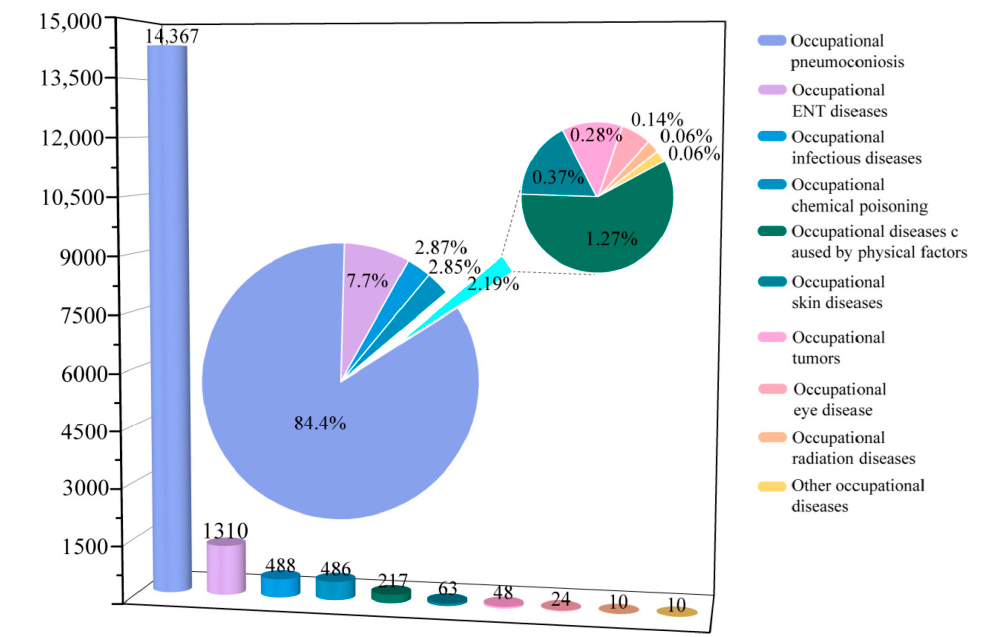
Figure 1. New vocational disease cases in China in 2020.